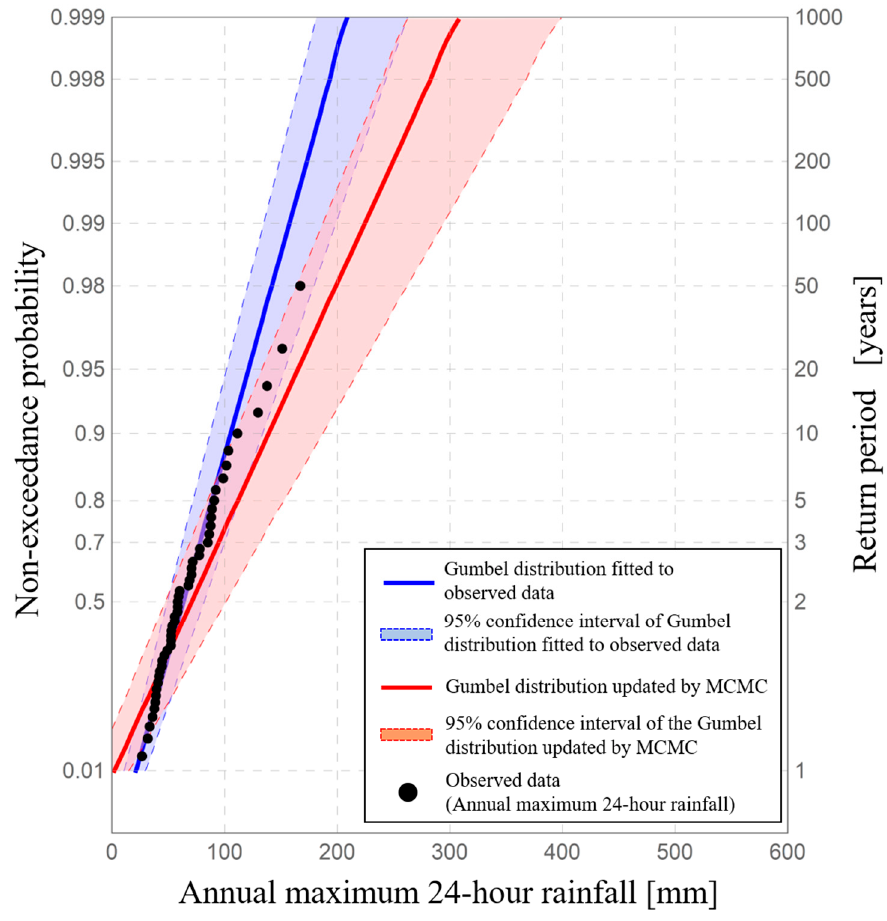
Figure 12. Update of confidence interval using Bayesian method that assimilates ensemble high- resolution climate projection